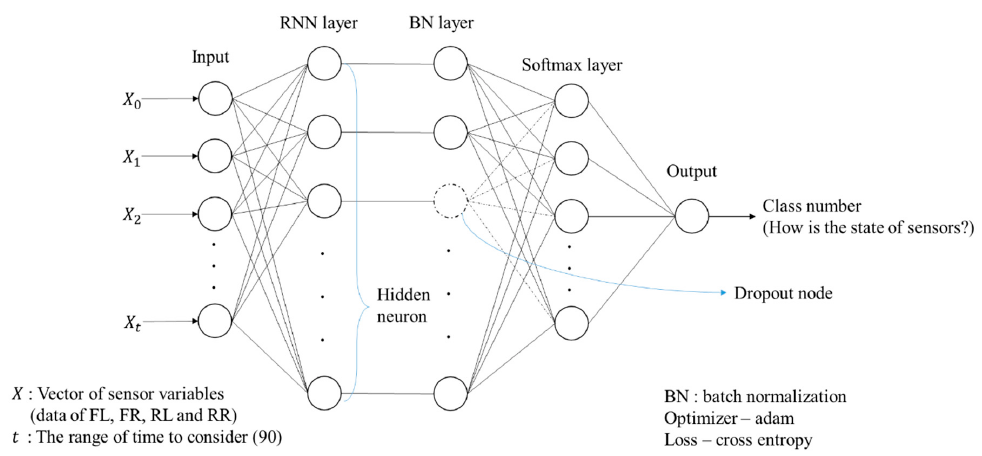
Figure 3. Selected RNN architecture. BN: Batch Normalization.